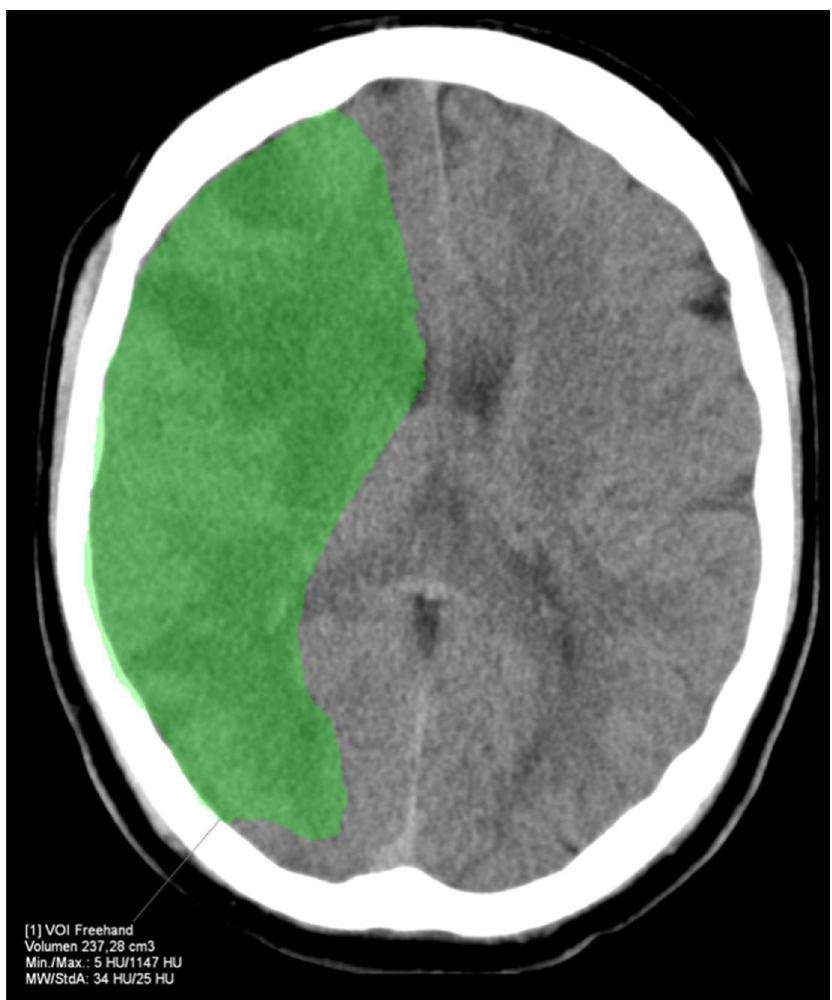
Figure 4. FIV of the example patient from Figure 3 24 h after futile recanalization. The FIV corresponds well with the HV indicated by RAPID.